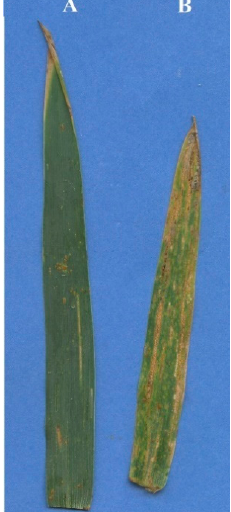
Figure 3. Symptoms of leaf rust caused by P . triticina on the leaves of bread wheat cv. Torka ( A ) and spelt-wheat line 18 ′ (S13 × T) ( B ).